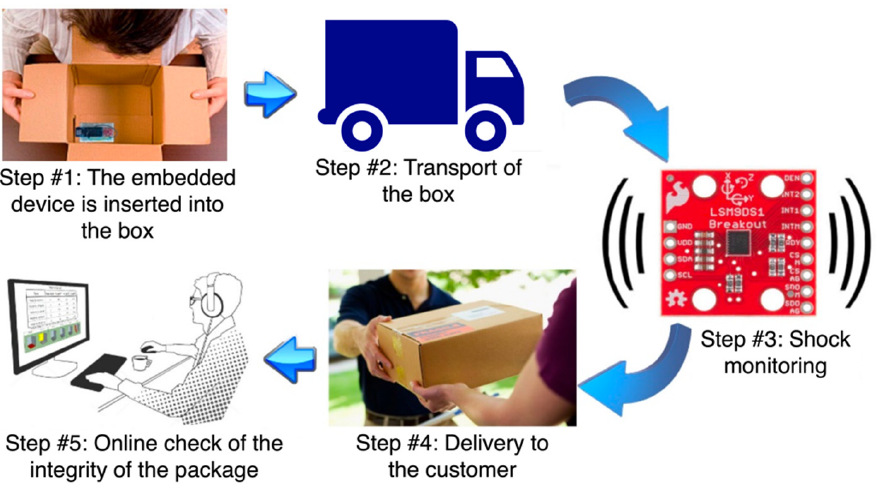
Figure 5. Stages of the shock monitoring system for the transport of goods. From a developer perspective, the system involves handling two distinct